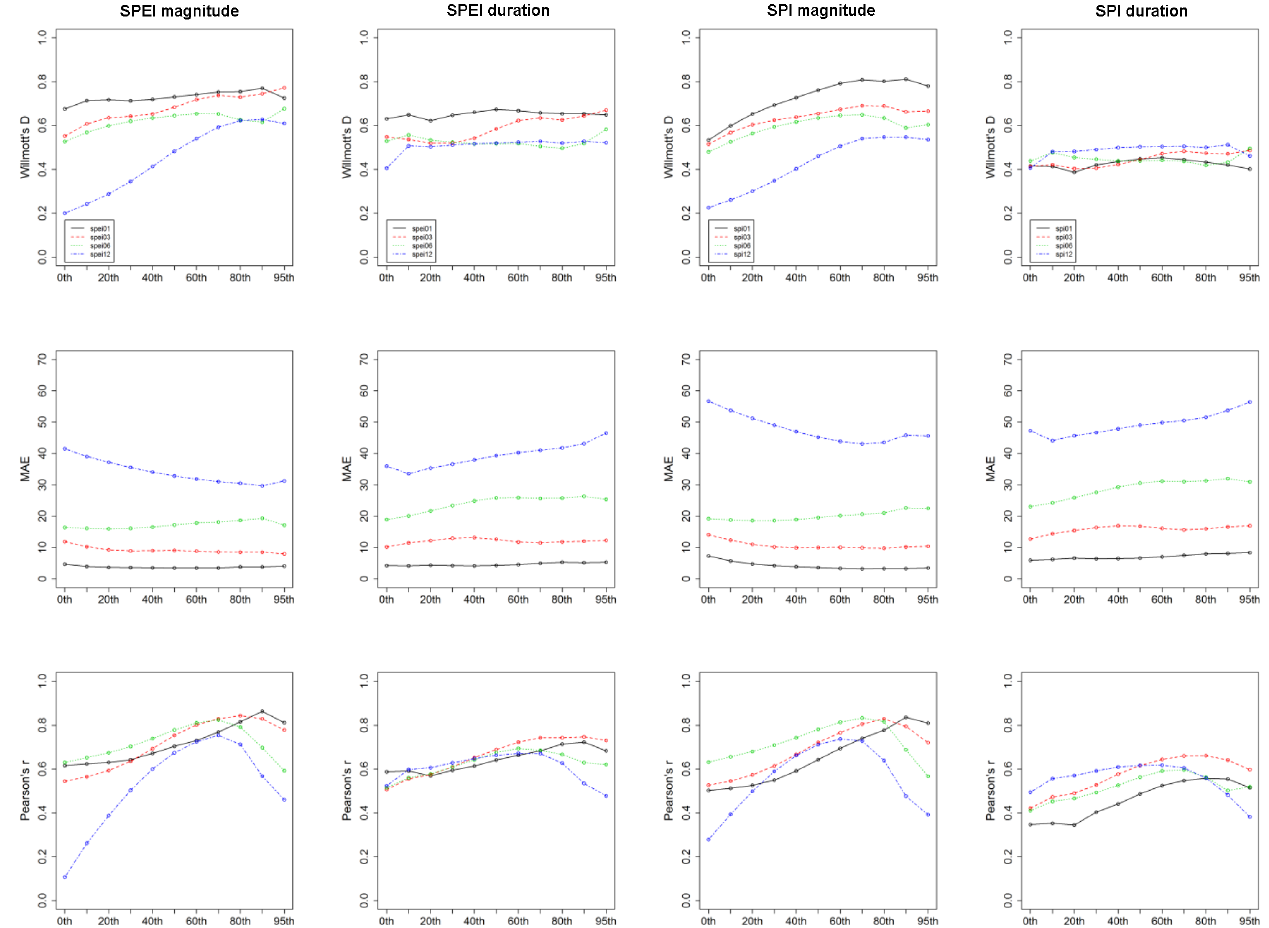
Figure 4. Willmott’s D , mean absolute error (MAE), and Pearson’s r summarized as a function of the different percentiles used to obtain the peak-over-threshold series. All accuracy metrics were computed based on comparing the maximum observed and modelled 1-, 3-, 6-, and 12-month SPI and SPEI drought duration and magnitude between 1961 and 2014. The modelled data were computed using the generalized Pareto